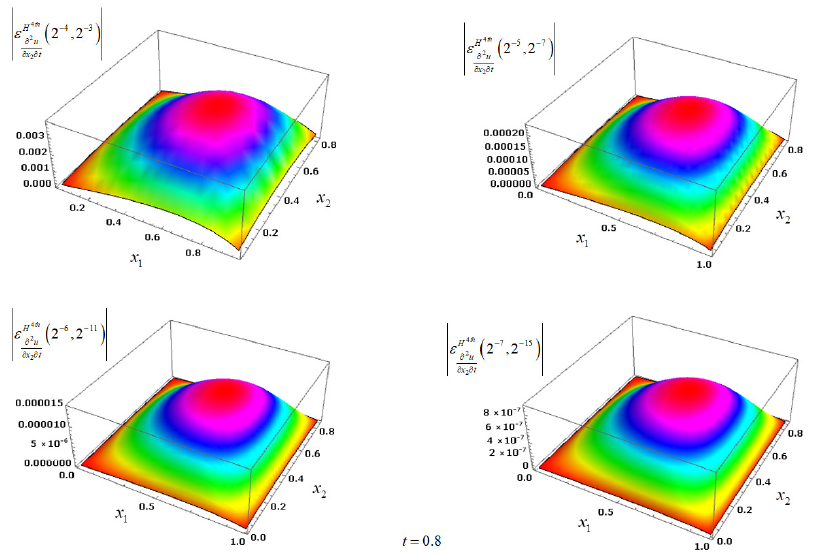
(cid:16) (cid:17) ∂ 2 u for ∂ x 2 ∂ t